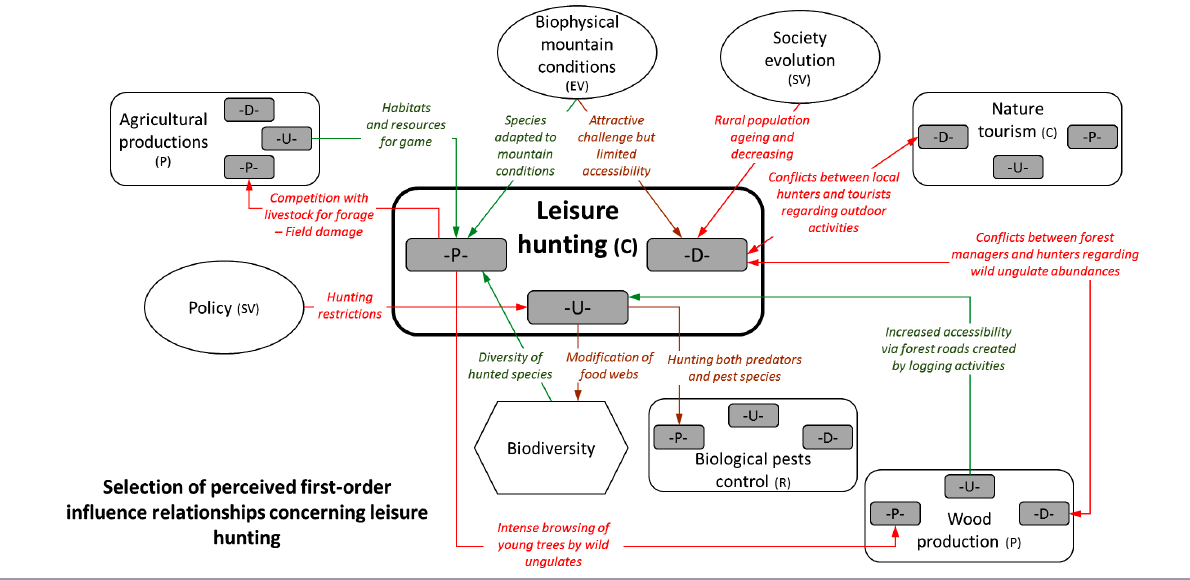
Fig. 5 . Example of an influence network centered around leisure hunting, as discussed by stakeholders during the consultative process. This network is built from a selection of first-order relations related to the leisure hunting ecosystem service (ES; Appendix 2). Influences concern all variable categories: provisioning ES (P), cultural ES (C), regulating ES (R), biodiversity, social variables (SV), and ecological variables (EV). Green arrows represent a positive influence or a synergy, red arrows a negative influence or an antagonism, and orange arrows describe influences with either positive and negative aspects, or varying ones.